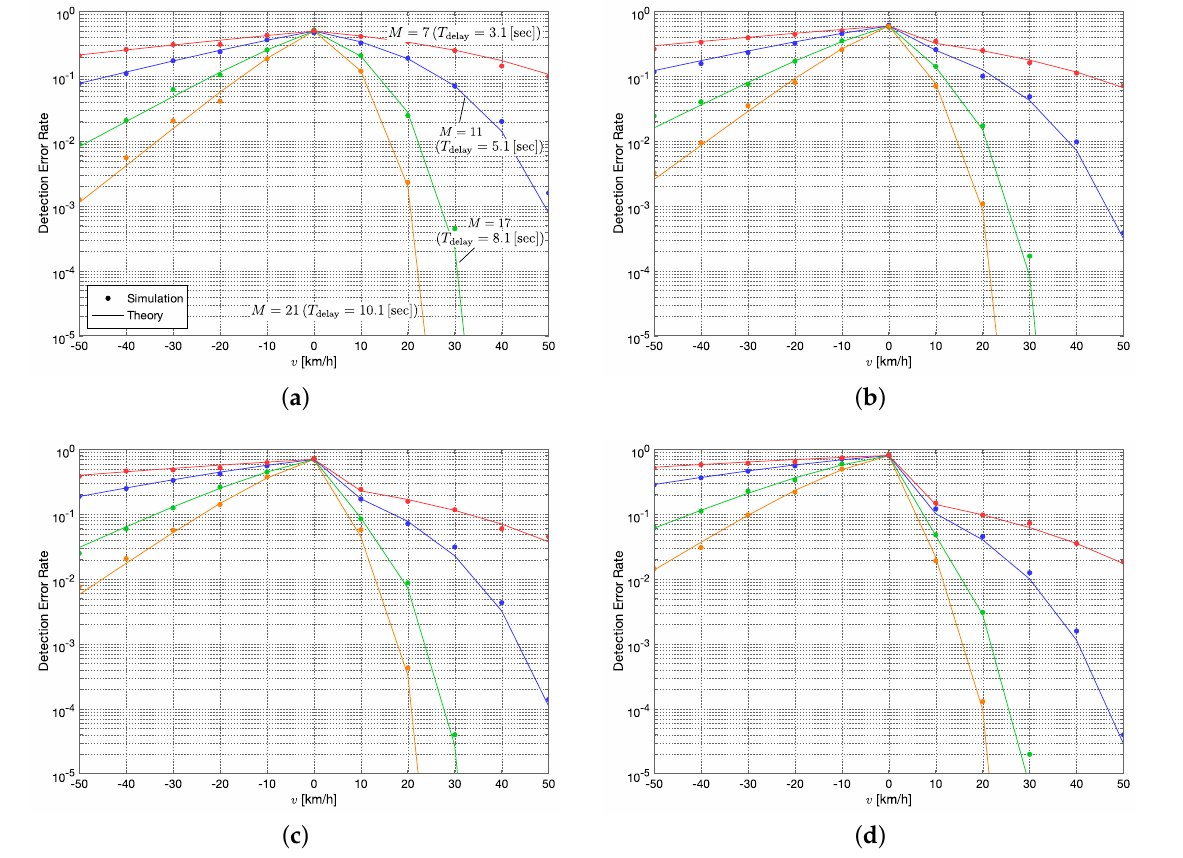
Figure 6. Detection error rate vs. vehicle velocity v for the ND-based method with ∆ T = 0.5 s and various M . ( a ) α 0 = 0.5; ( b ) α 0 = 0.4; ( c ) α 0 = 0.3 and ( d ) α 0 = 0.2. The detection error rates for v >